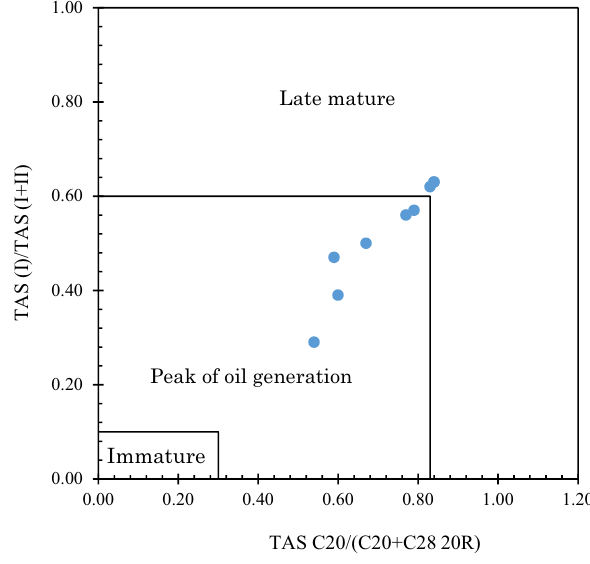
Fig. 5 Triaromatic steroid maturity parameters for the South Dezful Embayment’s oils (after Mackenzie